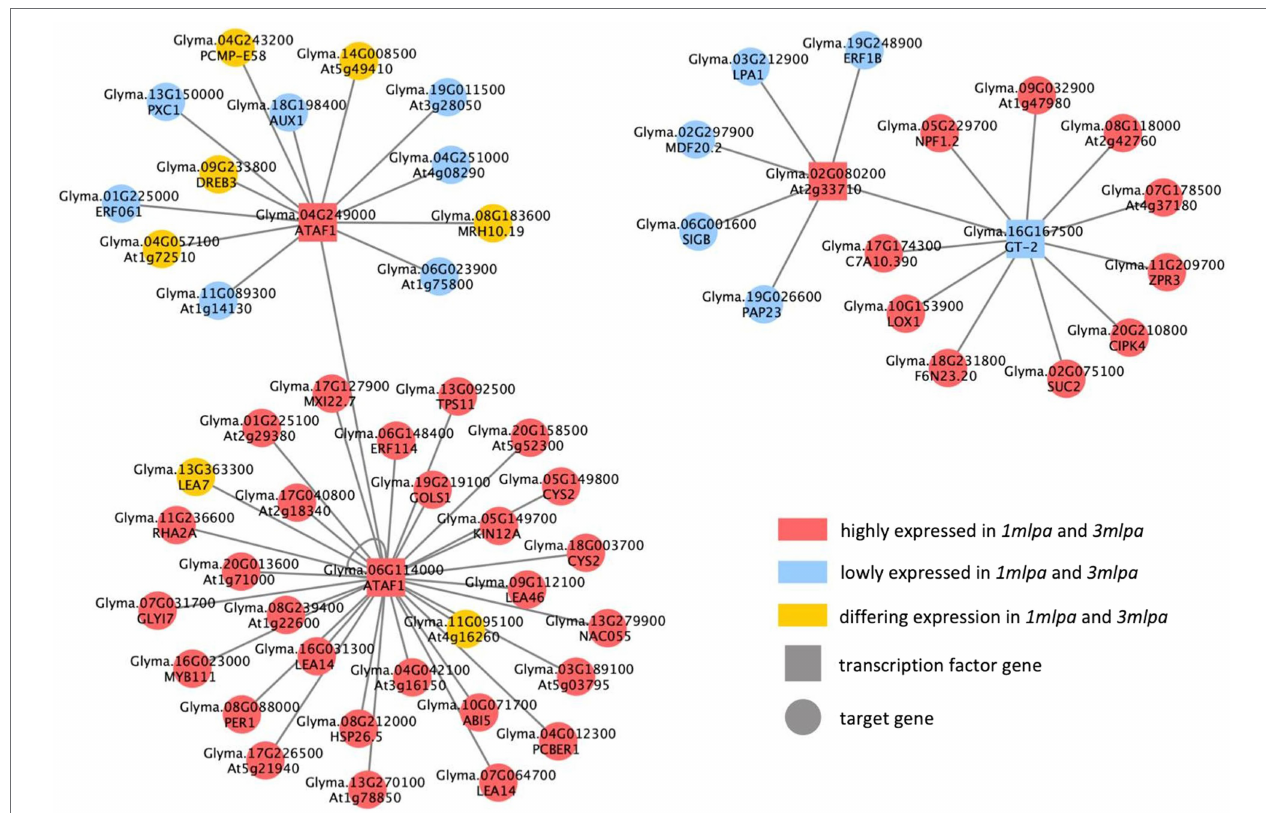
FIGURE 5 | Consensus gene regulatory network (GRN) of Mips and Mips-MRP genotypic subsets. GRN of putative regulatory interactions between differentially expressed transcription factor (TF) genes and differentially expressed target genes found in both the Mips and Mips-MRP GRNs. TF genes (square nodes) directly regulate (gray edges) target genes (circular nodes). Nodes in red are genes with increased expression in 1mlpa and 3mlpa . Nodes in blue are genes with decreased expression in 1mlpa and 3mlpa . Nodes in yellow are genes with differing expression in 1mlpa and 3mlpa